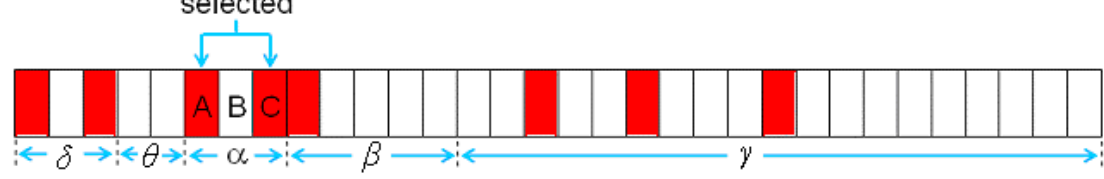
Figure 3. Example indicating that only Features A and C are selected as the crucial frequency bands, whereas Feature B is not selected.